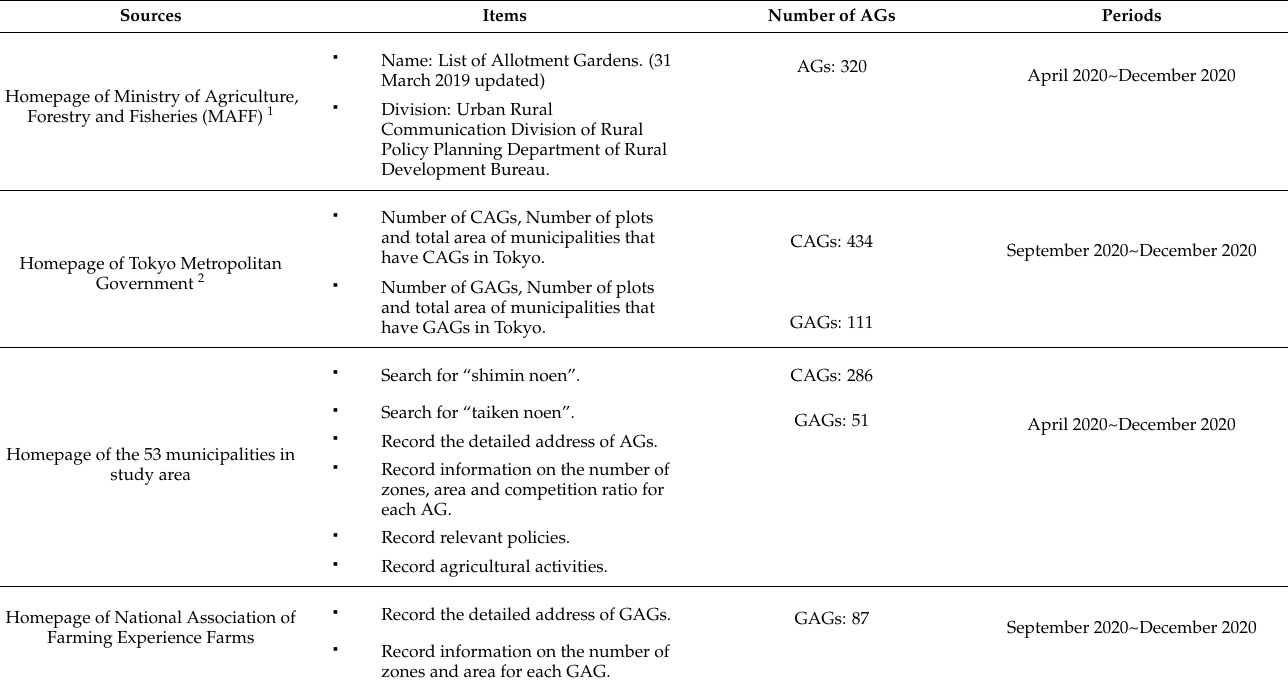
Table 1. Relevant legal basis for the provision of AGs in Japan.